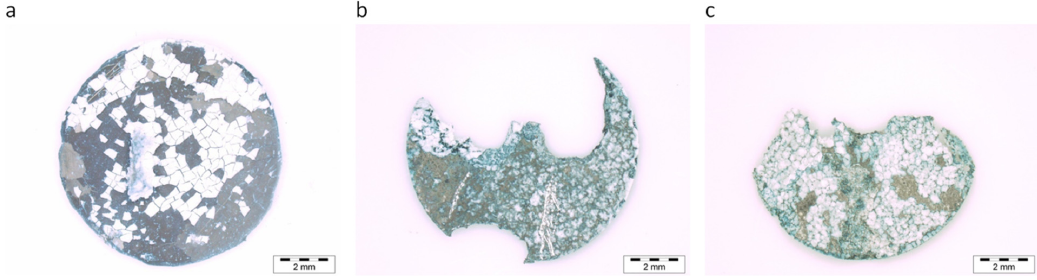
Figure 5. Stereo microscope images of samples X03 ( a ), Z5 ( b ) and ZX50 ( c ) after immersion in SBF.